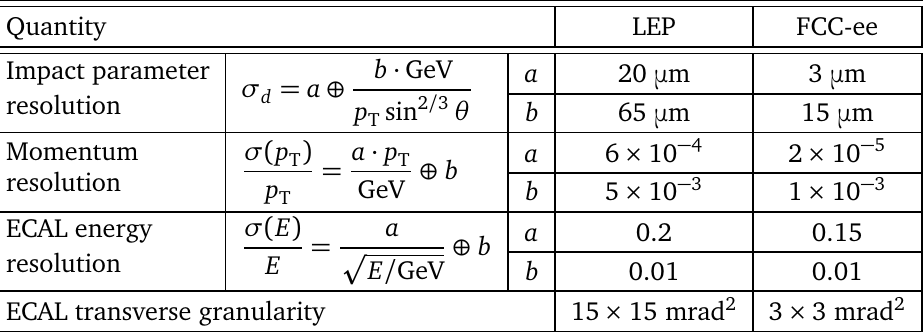
Table 2: Important performance figures for a typical detector at FCC-ee and at LEP Quantity LEP FCC-ee Impact